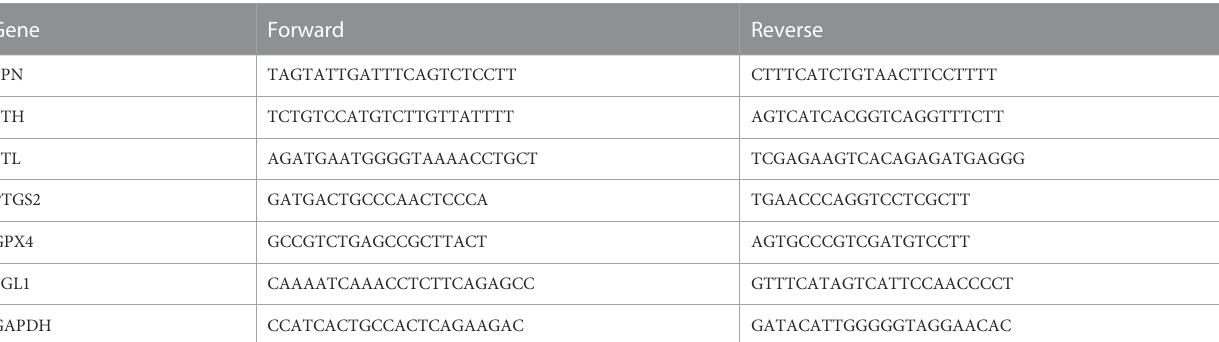
TABLE 3 Primer sequences used in